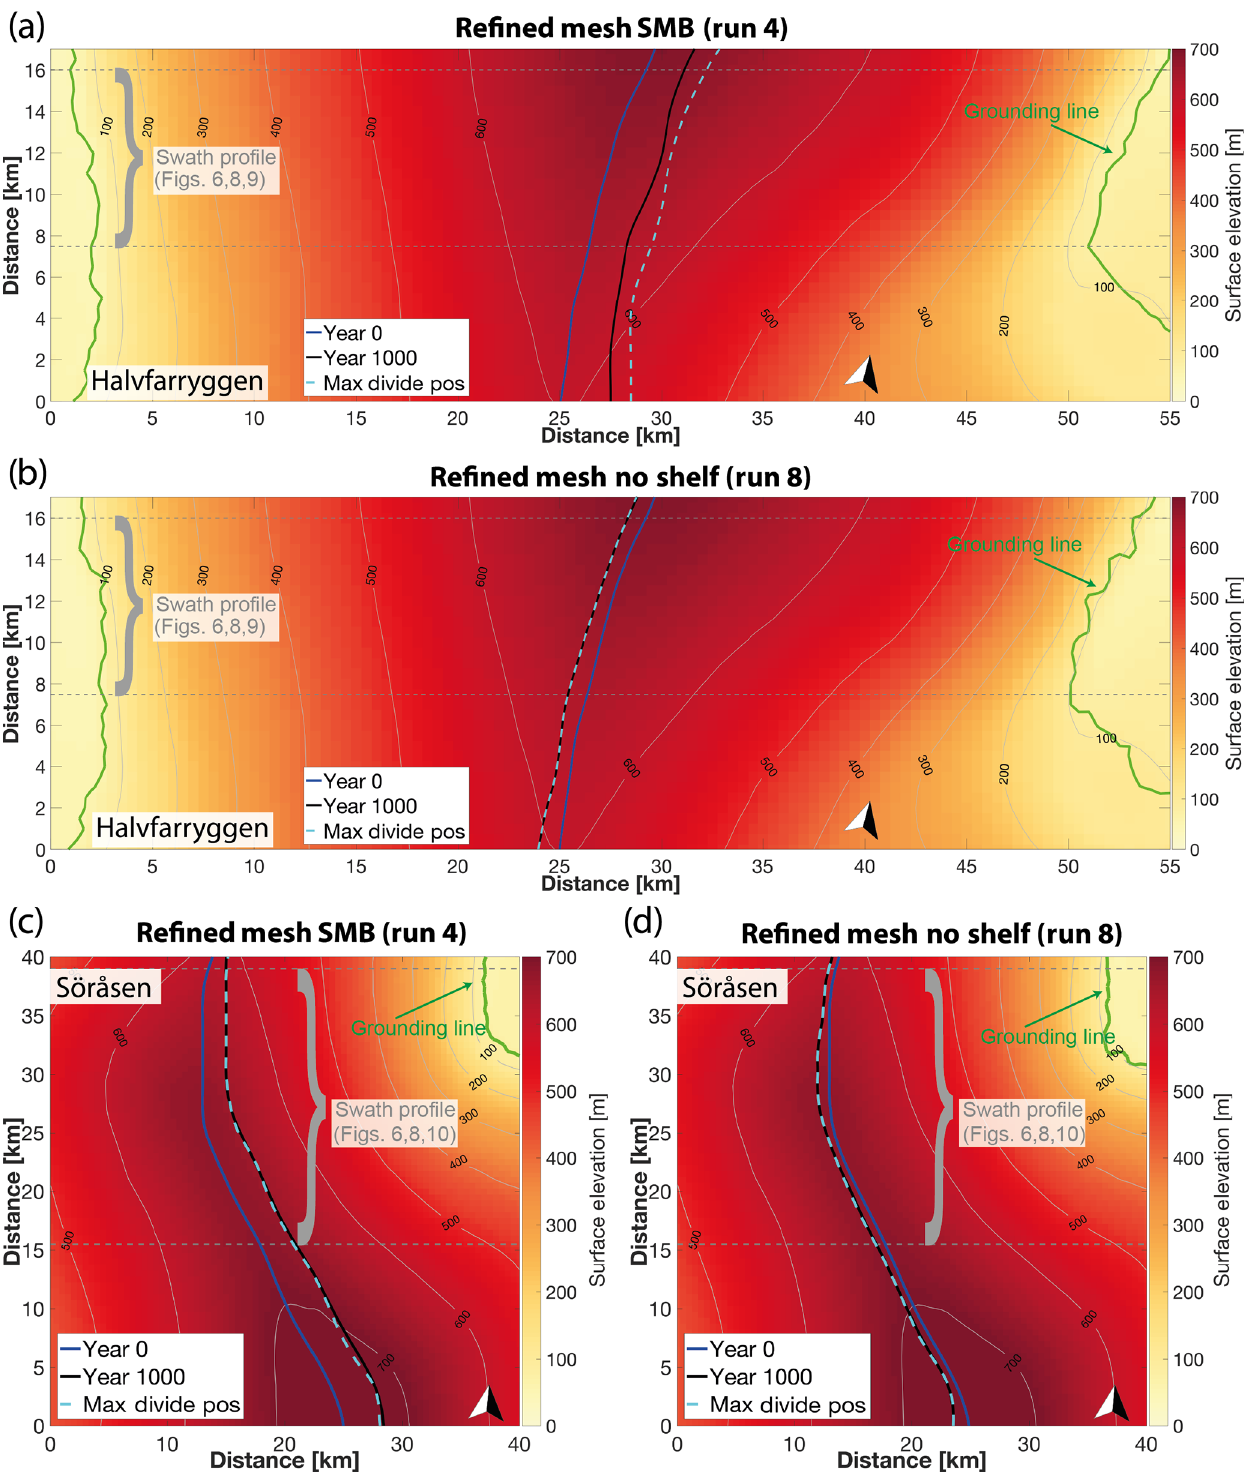
Figure 7. Ice-rise divide positions using the refined mesh for the Halvfarryggen Ice Rise induced by (a) surface mass balance perturbation and (b) shelf removal perturbation. Panels (c) and (d) show the same simulations for the Söråsen Ice Rise. Divide positions are plotted at the start of the simulation, at the end of the simulation, and at the time of maximum divide-migration amplitude for each simulation.